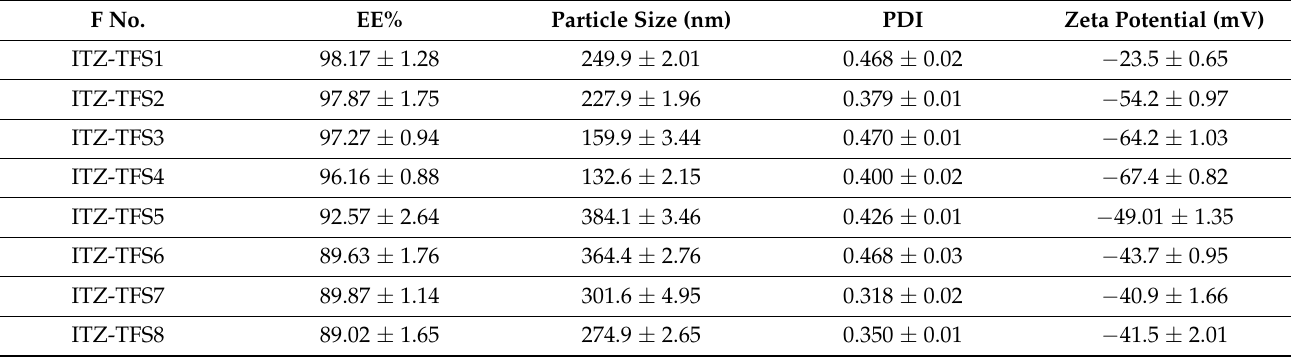
Table 3. The characterization of ITZ-TFS